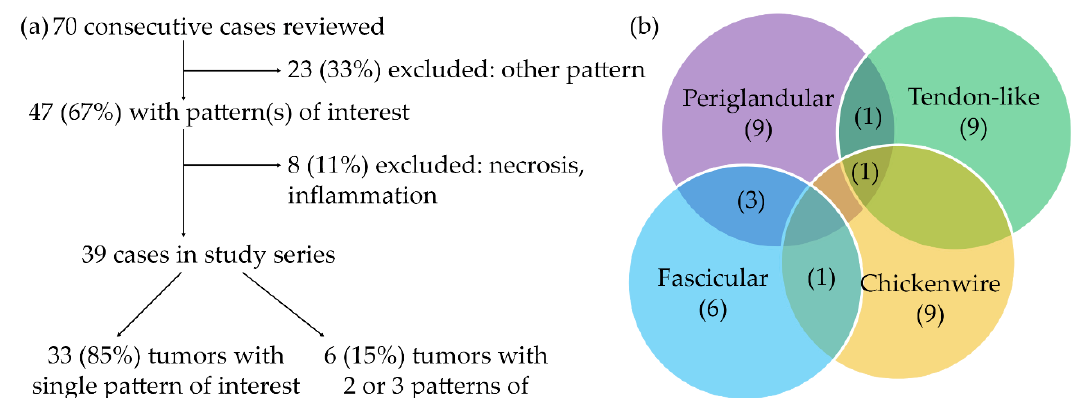
Figure 2. Case selection process and study series composition. ( a ) Flow chart depicting the selection process resulting in the study series. ( b ) Venn-diagram illustrating the number of tumors with a single, two or three different patterns.